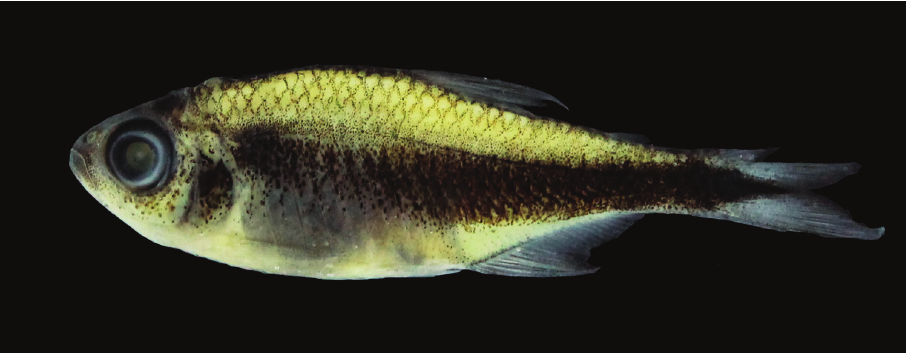
Figure 1. Hyphessobrycon klausanni sp. n., UARC-IC 539, holotype, male, 23.1 mm SL, Mapiripán County, upper Guaviare River drainage, Caño Claro, Meta,